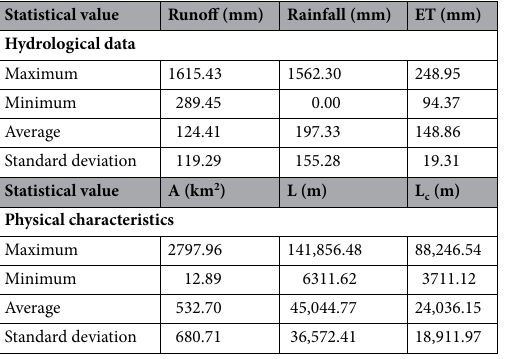
Table 1. Summary statistical values of hydrological data and physical characteristics of runoff gauged station used in this analysis.